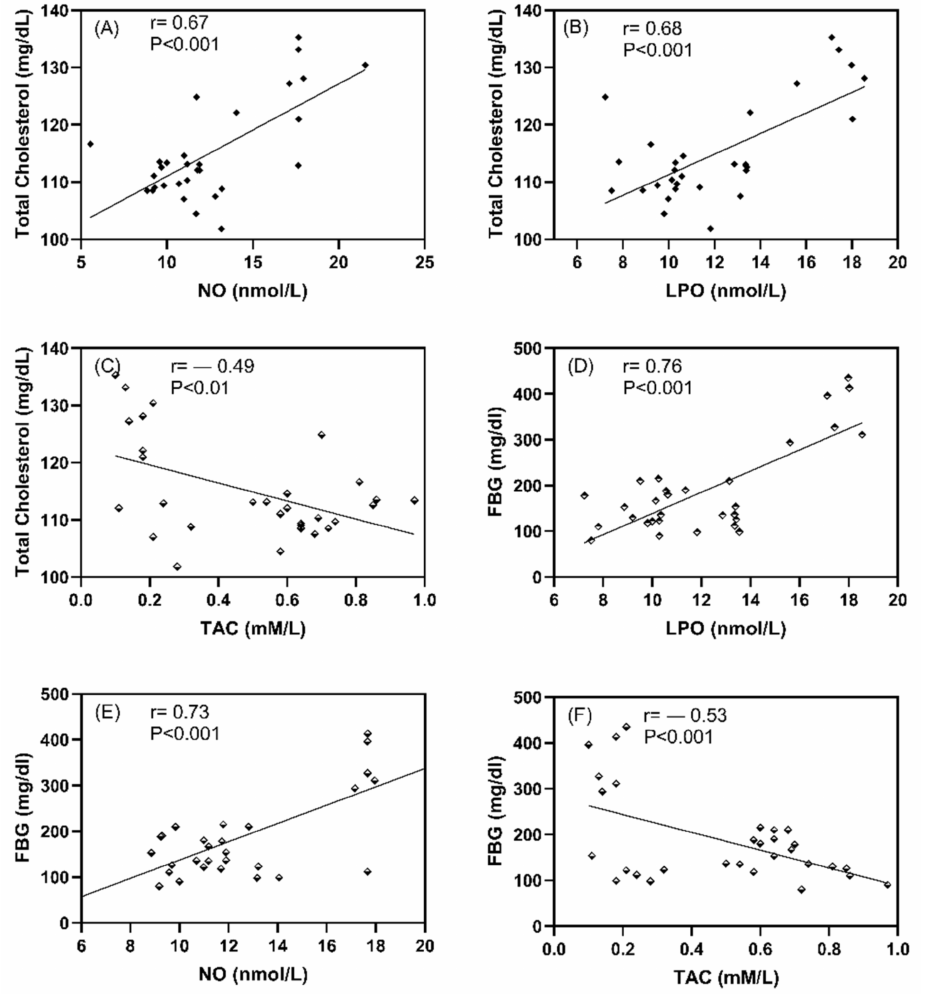
Figure 6. The correlation coefficient between studied oxidative stress markers and FBG and choles- terol in all studied rats; ( A ) Total cholesterol vs NO, ( B ) Total cholesterol vs LPO, ( C ) Total cholesterol vs TAC, ( D ) Total FBG vs LPO, ( E ) FBG vs NO, and ( F ) FBG vs TAC. Data expressed as correlation coefficient (r) values and p < 0.001 indicates the significant difference between studied